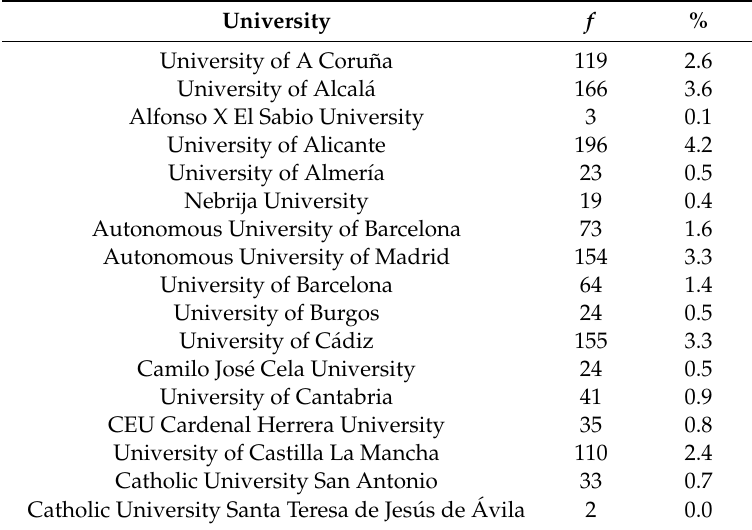
Table 1. Participant sample according to the university.